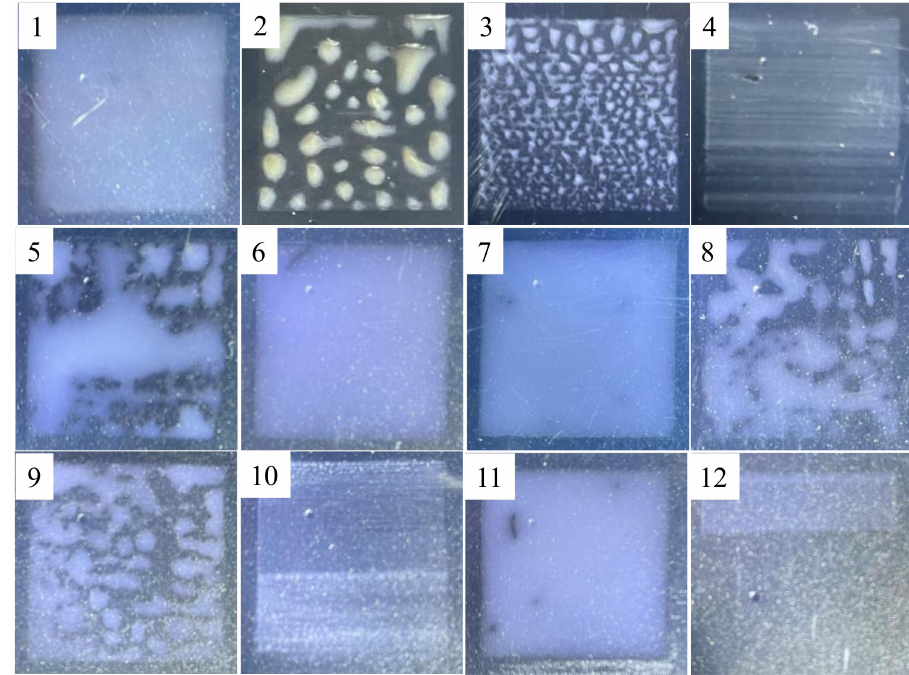
Figure 2. Photographs of the wet liquid film printed once with AgNWs inks in Table